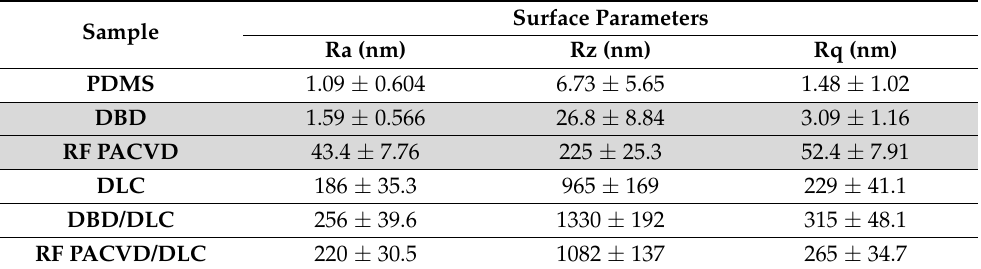
Table 2. Roughness parameters of the surface of the PDMS substrate: unmodified, and modified in RF PACVD plasma and in DBD plasma, and, furthermore, the same surfaces with DLC